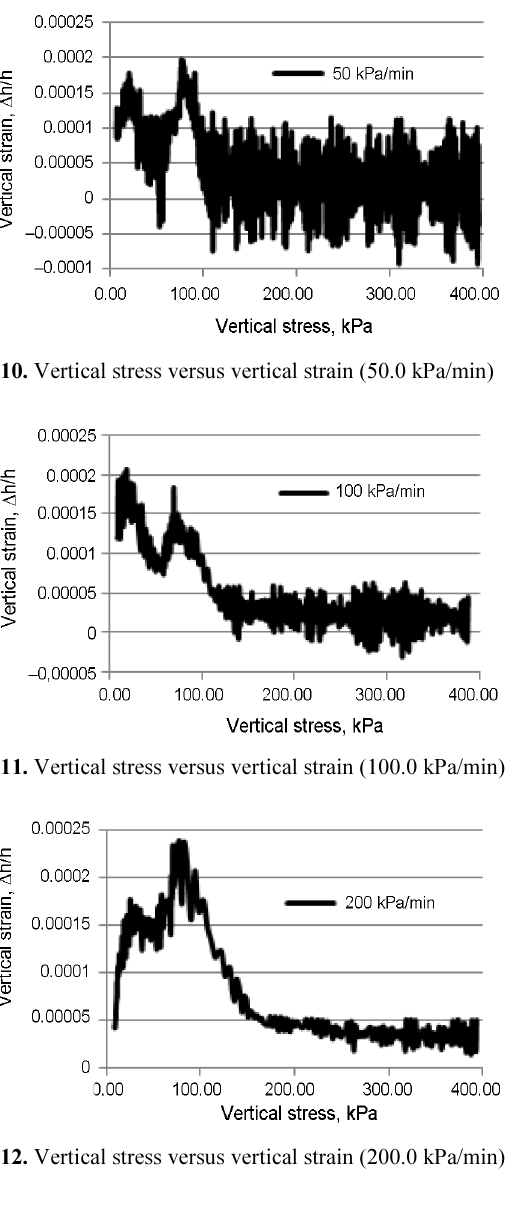
Fig. 9. Vertical stress versus vertical strain (25.0 kPa/min)